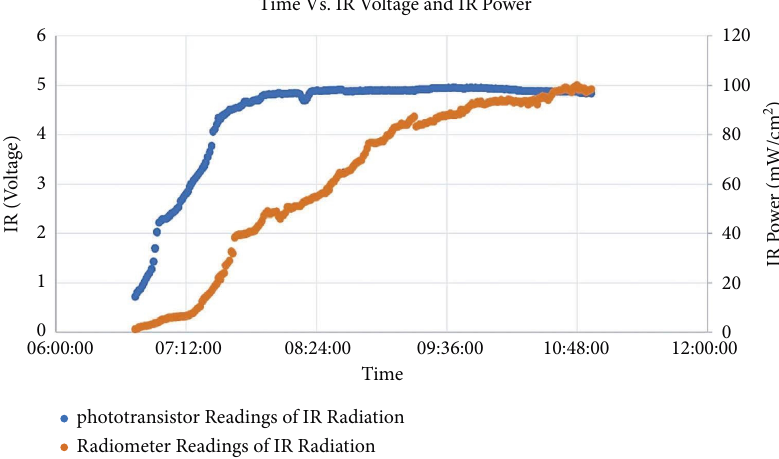
Figure 9: Te relationship between time, IR voltage (blue), and IR irradiance (orange).